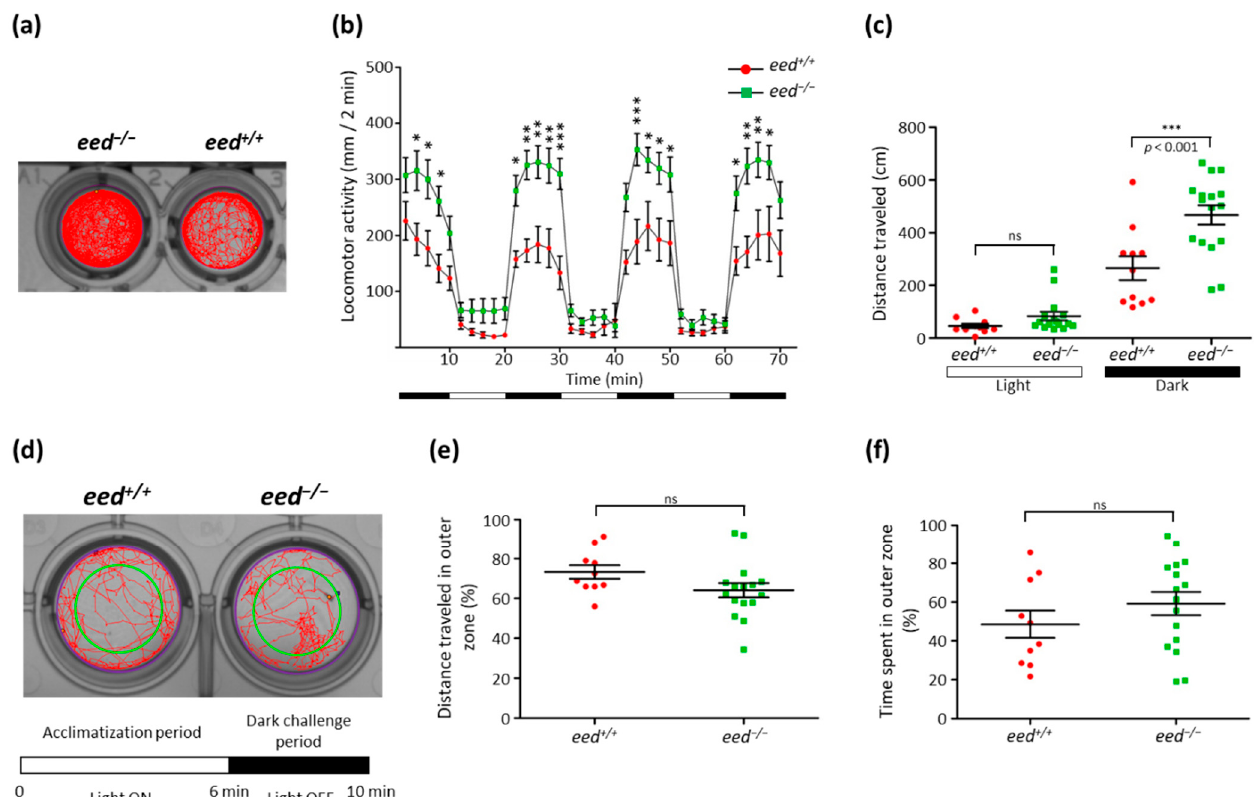
Figure 8. Behavioral comparison between wild-type and eed − / − mutants at 5 dpf: ( a ) locomotor tracking for a 70 min recording of an eed − / − mutant (left) and a wild-type (right) larvae; ( b ) distance traveled throughout a 70 min session for wild-type (red, n = 11) and eed − / − mutant (green, n = 16). Data are presented as mean ± SD of the distance moved (in mm) in 2 min intervals. Black and white bars at the bottom indicate dark and light conditions, respectively. Statistical analysis was performed using two-way ANOVA followed by Bonferroni posttest comparisons; ns, non-significant; *, p < 0.05; **, p < 0.01; ***, p < 0.001; ( c ) cumulative distance traveled for each wild-type (red) and mutant (green) larvae during the light (left) and dark (right) periods. Statistical analysis was performed using one-way ANOVA followed by Bonferroni posttest comparisons; ns, non-significant; ***, p < 0.001; ( d ) the experimental procedure for the thigmotaxis assay is composed of a 6 min acclimatization period with the light ON followed by a 4 min visual motor challenge period with the lights OFF. Experiments are performed in a 24-well plate format. Inner and outer zones are delineated by the green circle in a way that the two zones cover equivalent spatial areas. The distance traveled during the dark challenge period is shown for two larvae; ( e ) cumulative distance traveled in the outer zone of wild-type (red, n = 10) and eed − / − mutant (green, n = 16) larvae. Each point represents individual larvae. No statistical (ns) difference was found between wild-type and eed − / − mutants; ( f ) cumulative time spent in the outer zone of wild-type (red, n = 10) and eed − / − mutant (green, n = 16) larvae. Each point represents unique larvae. No statistical (ns) difference was found between wild-type and eed − / − mutants. Thigmotaxis (or “wall hugging”) is a common behavioral endpoint used in preclini ‐